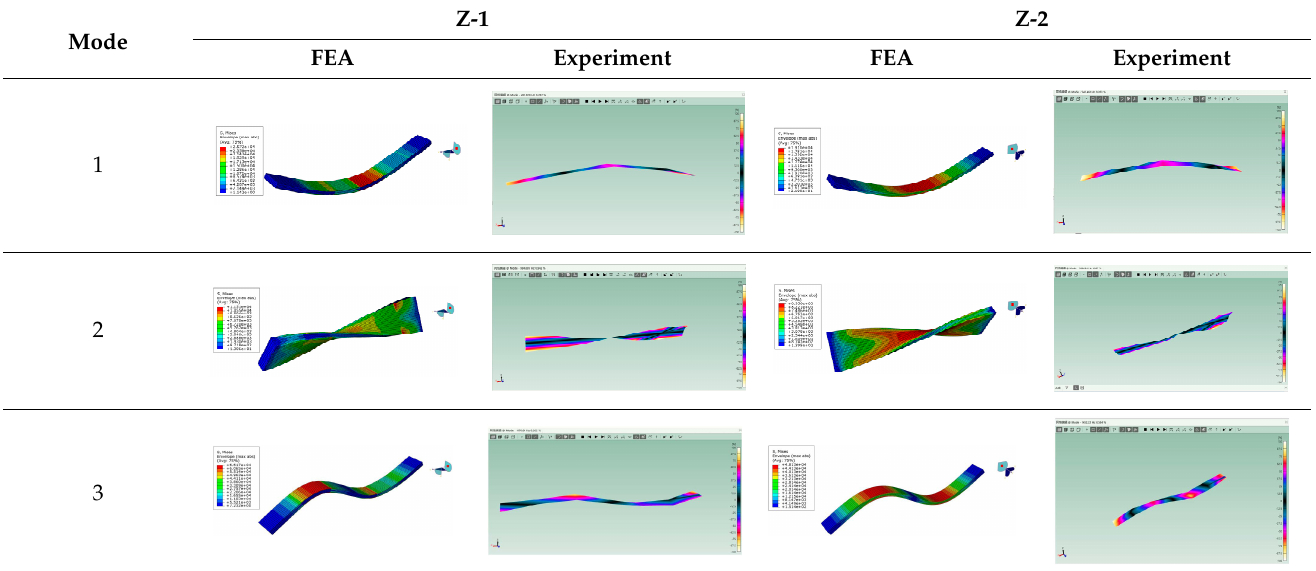
0.44 Table 7. Standard deviation of testing results. Group